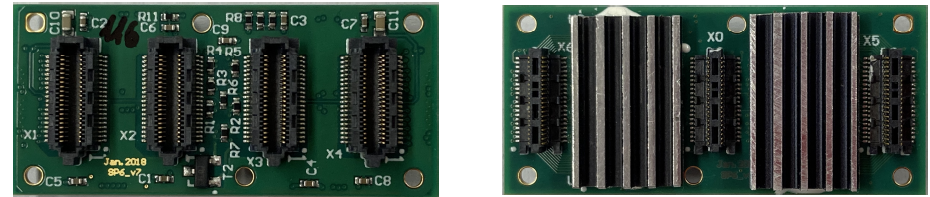
Figure 8. Image depicting the top and bottom side of the SP6. Four PETA6SE ASICs are located beneath aluminium heat sinks on the bottom side of the PCB, along with three male SAMTEC con- nectors (ST4-20-1.00-L-D-P-TR) which couple it to the SDIP, while the four female SAMTEC connect- ors (SS4-20-3.50-L-D-K-TR) on the top side are used to mount the MPPCs.